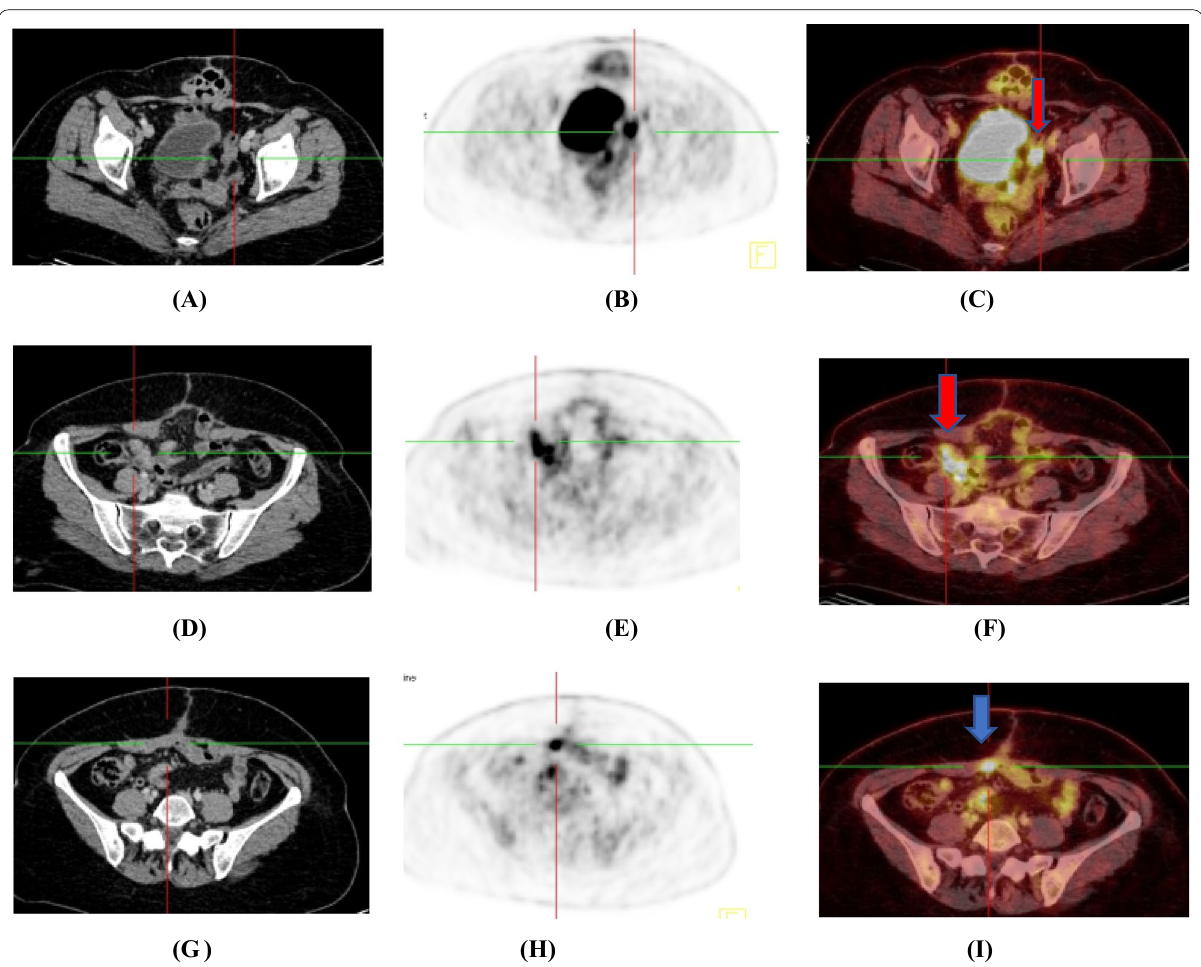
Fig. 6 A – F Axial CT, PET and PET/CT scan (3rd PET/CT follow‑up study) showing multiple newly developed FDG avid active omento‑peritoneal soft tissue nodules and progressed previously noted peritoneal deposits at the right iliac region (paracolic) measuring 3.4 (red arrows). G – I Axial CT, PET and PET/CT scan showing progressed omental nodules beneath anterior abdominal wall at level of Lv5 (blue arrow), measured 1.4 with SUV max =